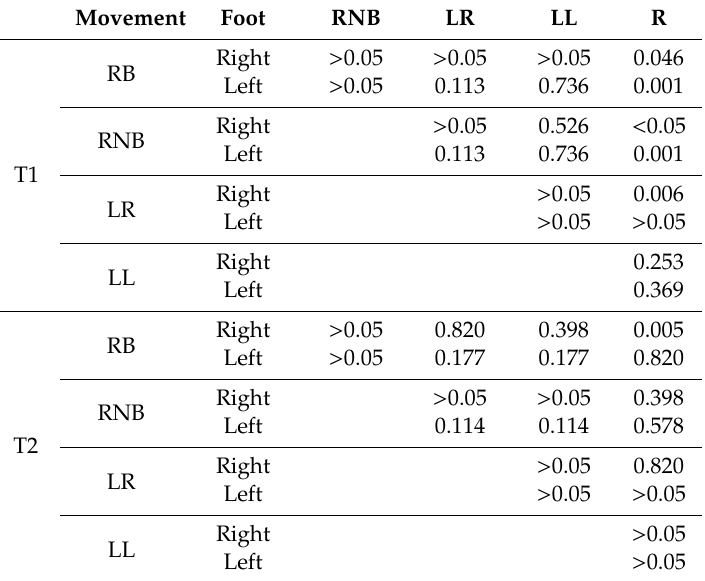
Table 5. Friedman test results comparing the five movements at T1 and T2,